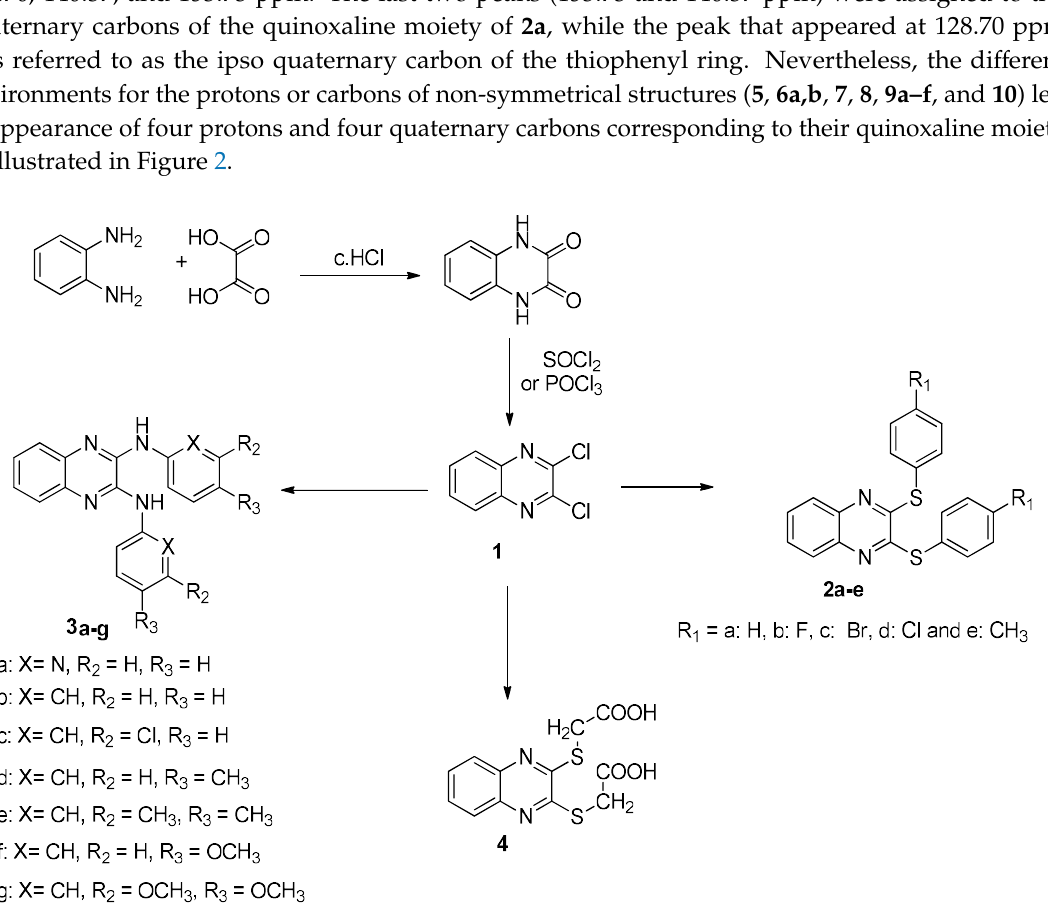
Scheme 1. Synthesis of sym. 2,3-disubstituted quinoxaline.